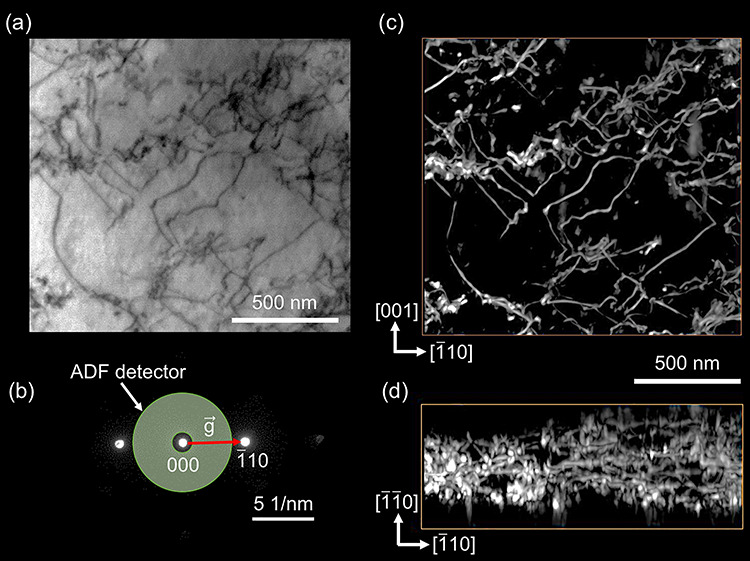
LAADF-STEM dislocation tomography for an α-Fe single-crystalline specimen with a foil normal to the (110) plane [64]. (a) The LAADF-STEM image at a specimen-tilt angle of 0°. The dislocations are visualized as dark lines. (b) The corresponding diffraction pattern and the location of the ADF detector for the LAADF-STEM imaging. Inelastically scattered electrons between the direct beam (000) and the diffracted beam (\documentclass[12pt]{minimal}
\usepackage{amsmath}
\usepackage{wasysym}
\usepackage{amsfonts}
\usepackage{amssymb}
\usepackage{amsbsy}
\usepackage{upgreek}
\usepackage{mathrsfs}
\setlength{\oddsidemargin}{-69pt}
\begin{document}
}{}$\overline{1}10$\end{document}) were detected by the ADF detector under the Bragg condition, K = g(\documentclass[12pt]{minimal}
\usepackage{amsmath}
\usepackage{wasysym}
\usepackage{amsfonts}
\usepackage{amssymb}
\usepackage{amsbsy}
\usepackage{upgreek}
\usepackage{mathrsfs}
\setlength{\oddsidemargin}{-69pt}
\begin{document}
}{}$\overline{1}10$\end{document}). (c) and (d) The projection views of the 3D reconstructed volume along [110] and [001], respectively. Large portions of the dislocation lines seem to lie parallel to the (110) plane since the {110} planes are dominant slip planes in the body-centered cubic α-Fe crystal. From the [001] projection in (d), the specimen thickness in the field of view is evaluated to be 300–400 nm.